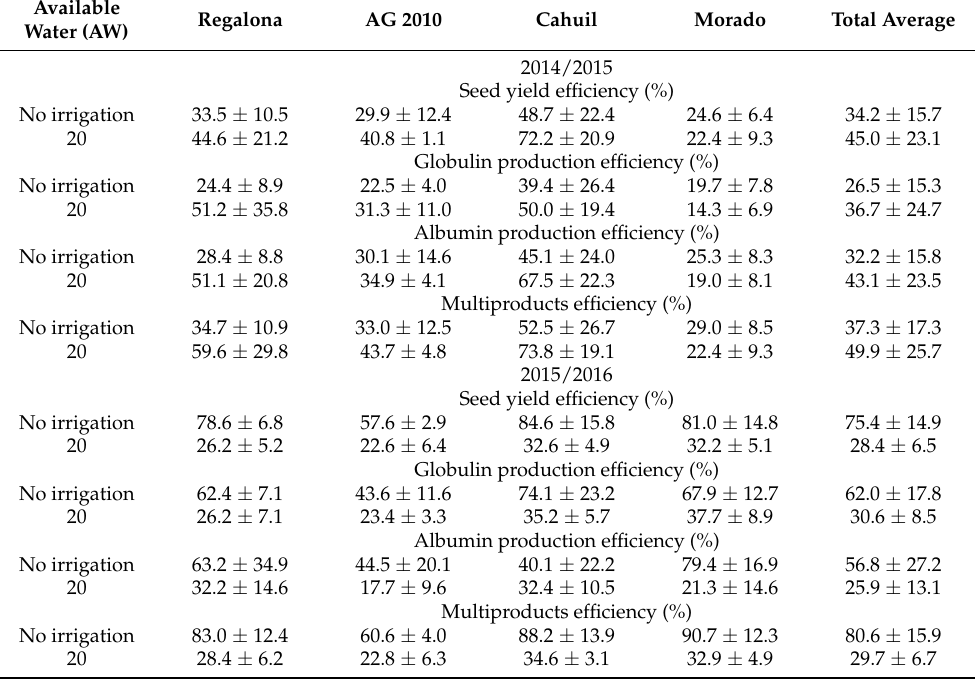
Table 3. Summary of average technical efficiencies under no-irrigation and 20% AW in the 2014/2015 and 2015/2016